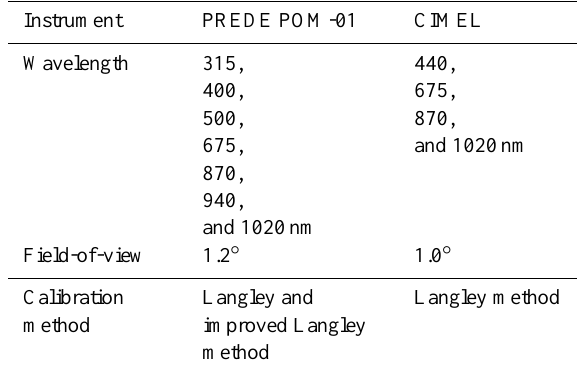
Table 1. POM-01 sky-radiometer and